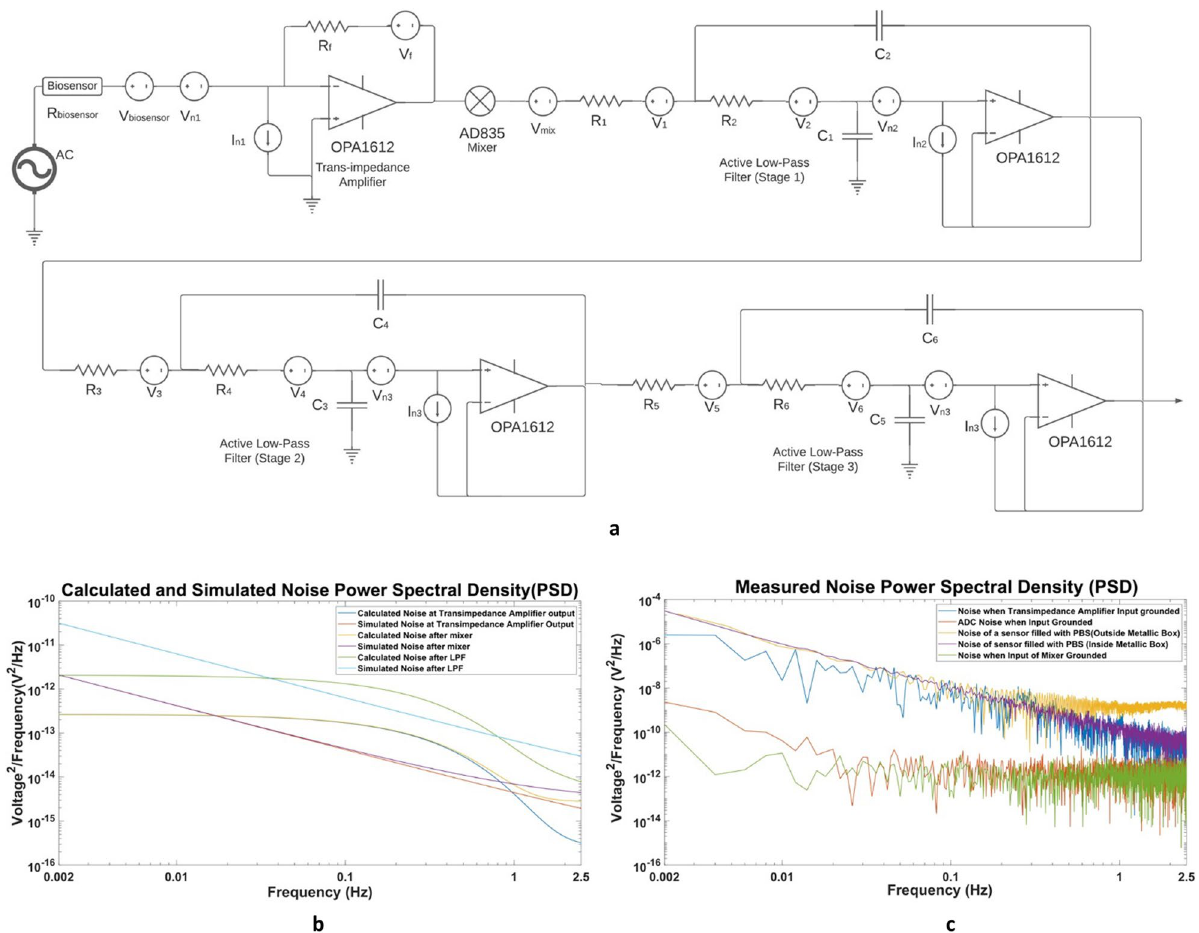
Figure 3. ( a ) Noise model of the lock-in amplifier ( b ) Calculated and Simulated Noise Power Spectral Density ( c ) Measured Noise Power Spectral Density under different conditions. Each case corresponds to a measurement time of 10